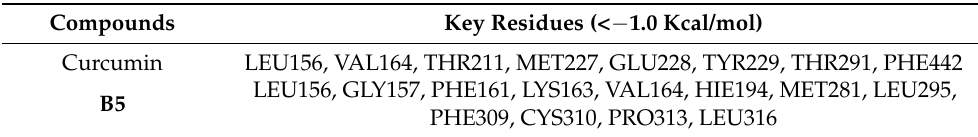
Table 3. Key residues of curcumin, B5 with AKT by decomposition free energy calculations. Compounds Key Residues (< − 1.0